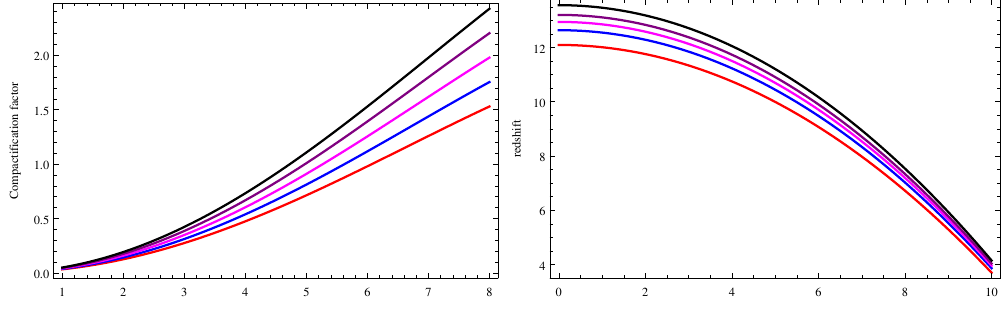
Figure 10. Plot of the compactification factor and redshift versus r for the strange star candidate LMC X − 4. The red, purple, magenta, blue and black colors represent respectively cases (cid:118) = 0, (cid:118) = 0.5, (cid:118) = 1, (cid:118) = 1.5 and (cid:118) =